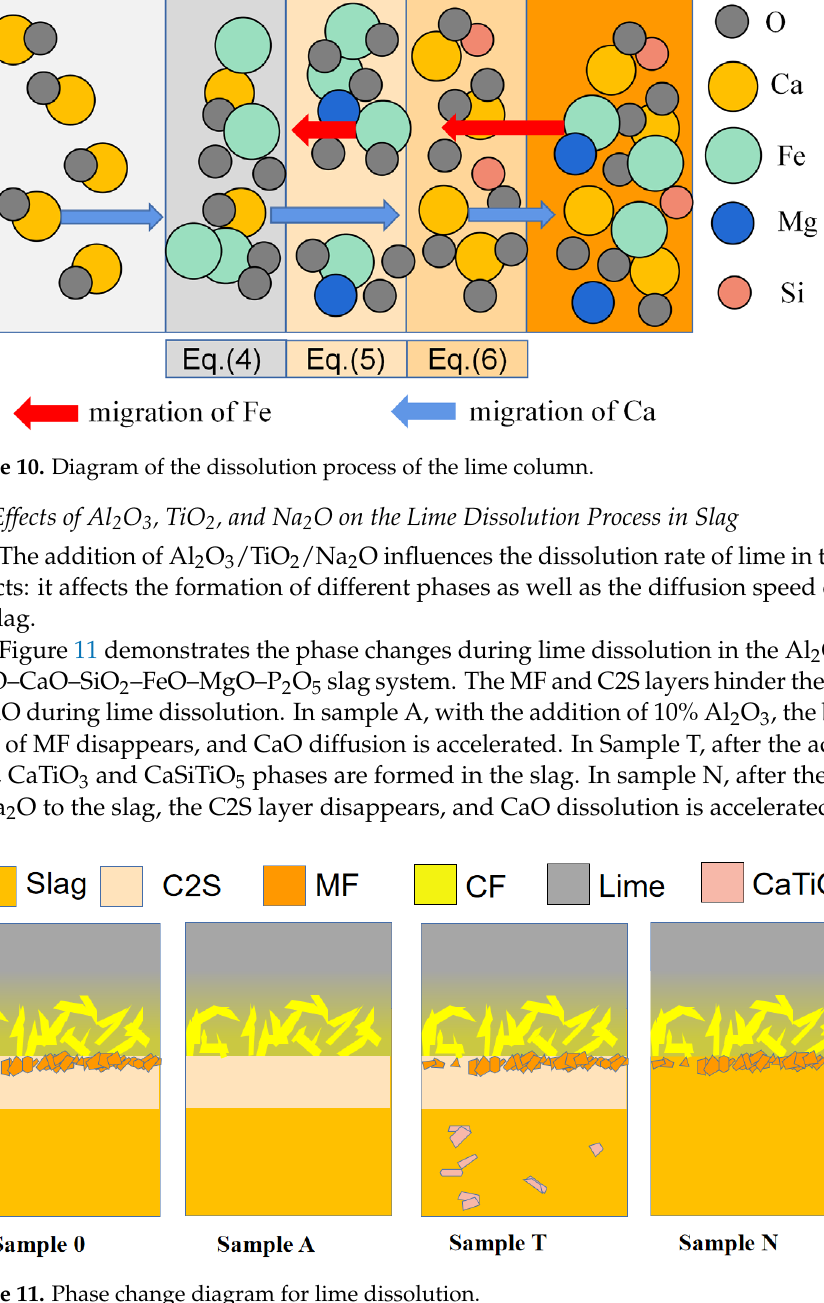
Figure 11. Phase change diagram for lime dissolution.